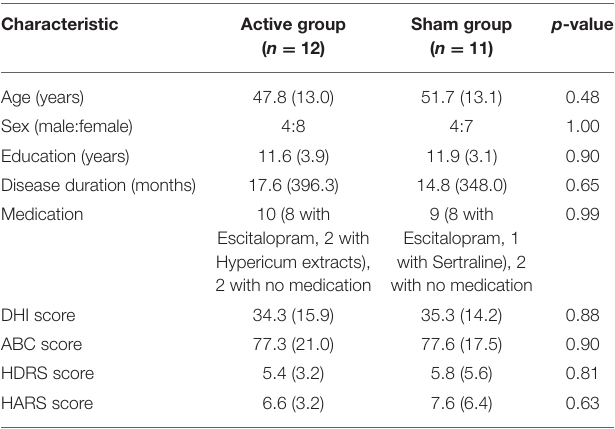
TABLE 1 | Baseline demographic and clinical characteristics of the study participants.